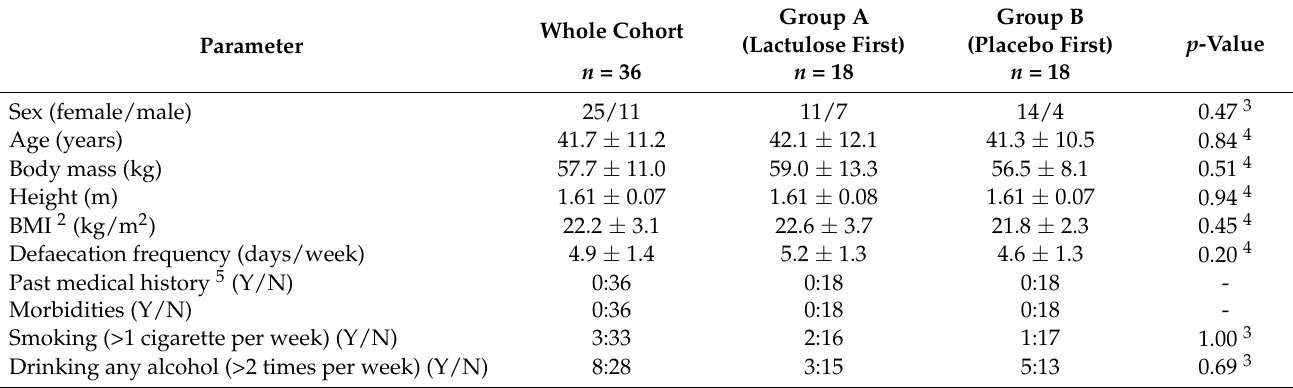
Table 1. Anthropometric data at the start of the trial 1